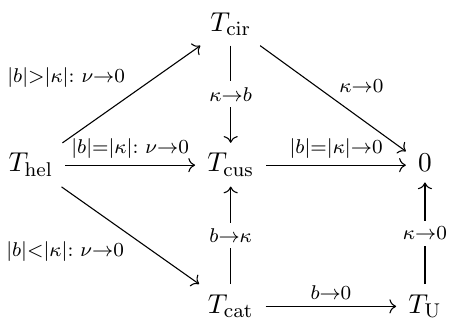
Figure 1 . Limits for the e(cid:11)ective, frequency-dependent temperatures recorded by detectors along stationary curves in Minkowski